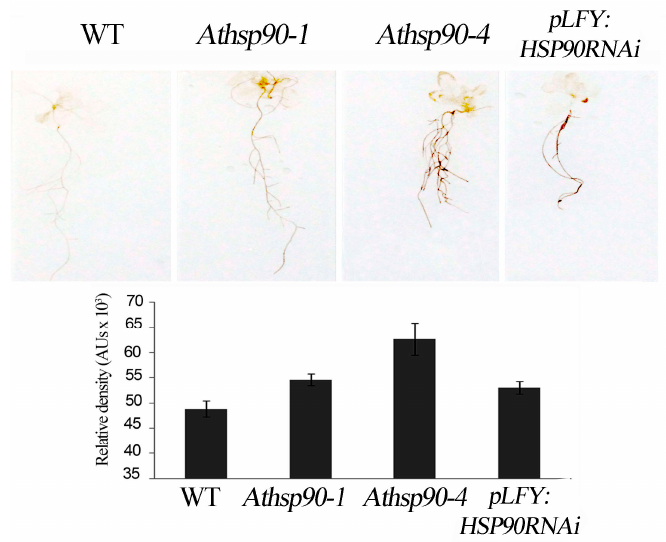
Figure 2. In situ DAB detection of hydrogen peroxide in WT, Athsp90-1 , Athsp90-4 and pLFY:HSP90RNAi seedlings of Arabidopsis thaliana grown on Murashige and Skoog (MS) plates and relative pixels density of leaf staining. Values from 8 replicates from two independent experiments were pooled for statistical analysis.